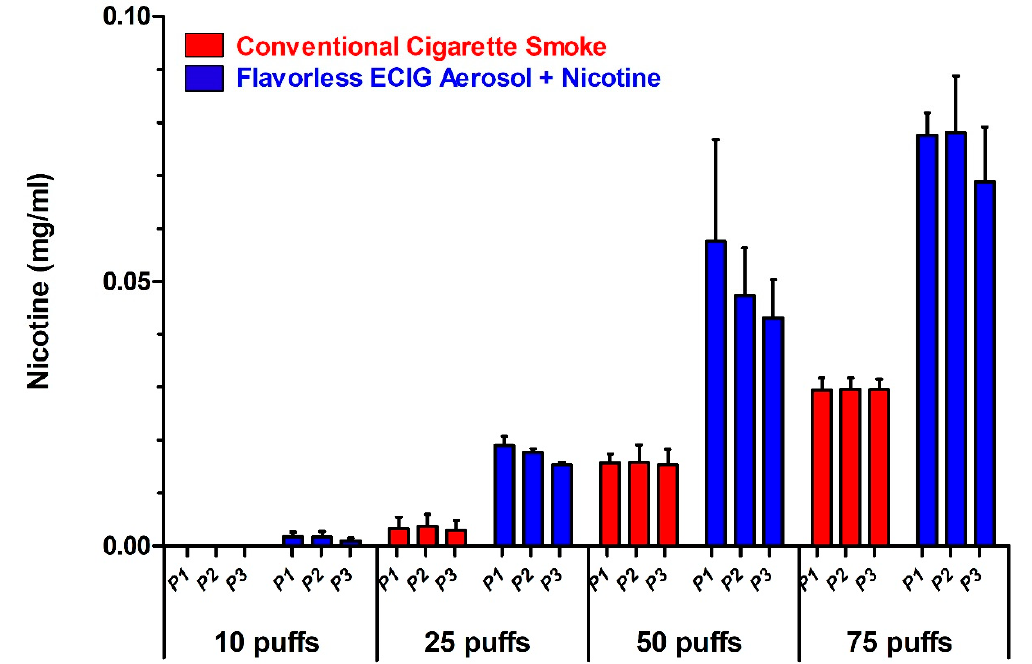
Figure 2. Levels of nicotine in three plates inside the exposure chamber. Nicotine concentrations (mg/mL) in three plates of brain heart infusion (BHI) broth (i.e., P1, P2 and P3) set up in tandem inside an exposure chamber after 10, 25, 50 and 75 puffs of flavorless ECIG aerosol containing 20 mg/mL nicotine or conventional cigarette smoke. Each data point is the Mean ± SE of 3 replicate exposures over 3 separate occasions ( n = 3).